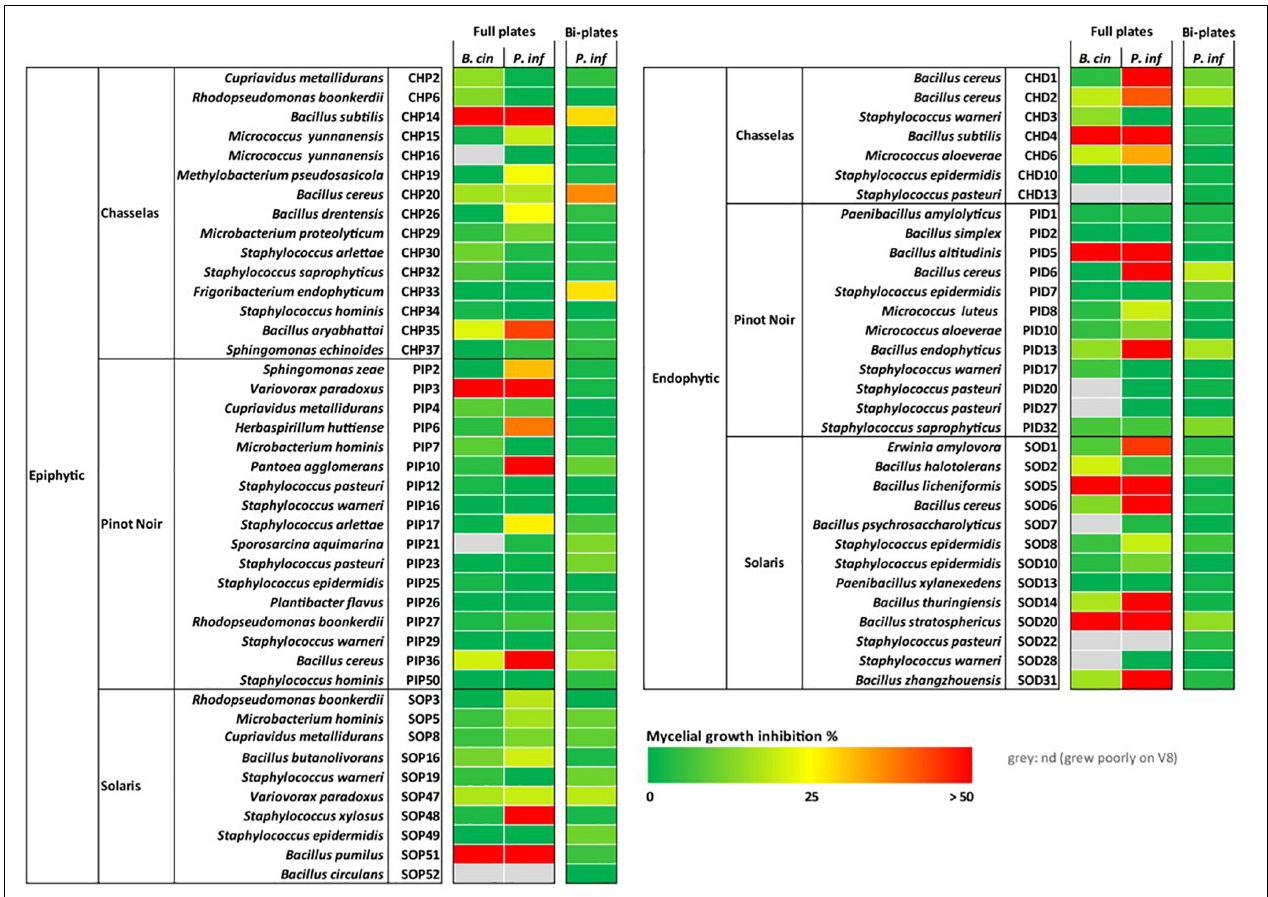
FIGURE 2 | Inhibiting activity of grapevine bacterial isolates on the mycelial growth of two phytopathogens. Strains were tested in standard (full) plates and two-compartment plates for in vitro inhibition of mycelial growth of Botrytis cinerea ( B. cin ) and of Phytophthora infestans ( P. inf ). Pathogens and bacteria were grown on V8 medium in both setups. Bacteria were grown on V8 for full plate assays and on LB for split plate assays. No inhibition of B. cinerea was observed using the two-compartment plate setup, therefore only data for P. infestans are shown. This experiment was performed with 3–5 replicates for each strain and a color code is shown with red indicating highest inhibition and green no inhibition or promotion of growth. The corresponding numerical data and statistical analysis are presented in Supplementary Table S2 . Four strains depicted in Figure 1 are not shown here because they grew poorly on V8 and on LB: CHD40, CHP28, PIP45, and PIP46. Species names of the strains correspond to the closest blast hits ( Supplementary Table S1